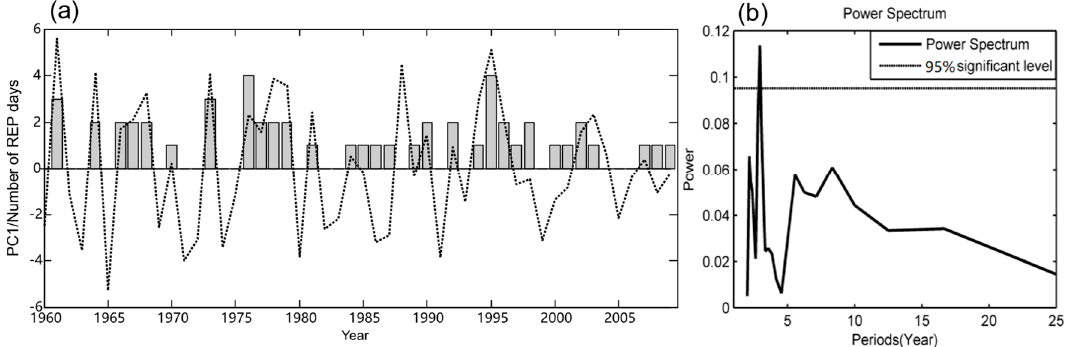
Figure 4. Interannual variability in the number of the REP days over the YRLV (gray bar) and the PC of the first EOFs (PC1, dashed line) of the station-based extreme precipitation days ( a ) and the power spectrum of PC1 ( b ).